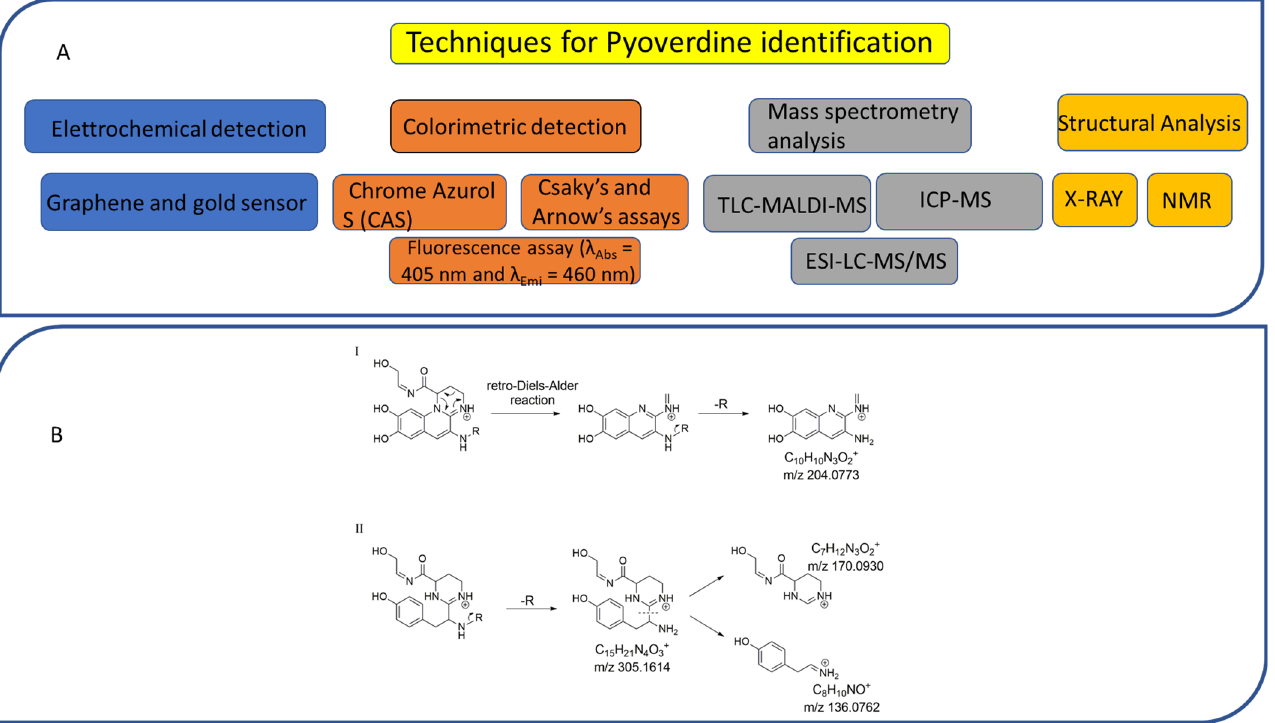
Figure 3. ( A,B ). Flow diagram reporting techniques and methods for PVD identification ( A ); MS fragmentation pathways leading to the formation of diagnostic fragment ions from the pyoverdine ( I ) and ferribactin ( II ) chromophores, as reported by Rehm and colleagues (171) ( B ).